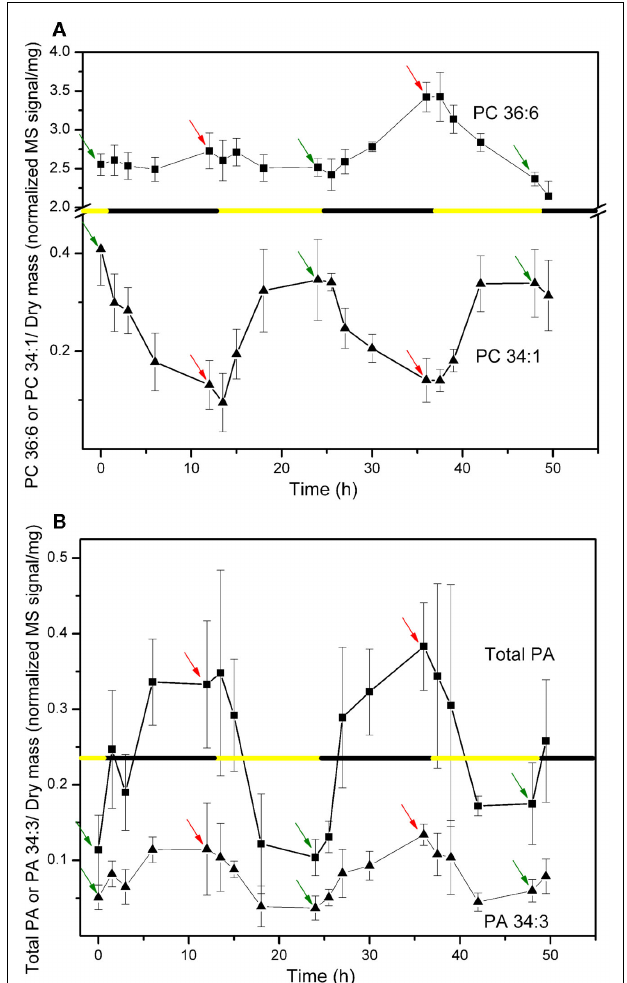
FIGURE 1 | Changes in lipid molecular species PC 36:6 and PC 34:1 (A) and PA lipid class and molecular species PA 34:3 (B) through 12-h light/12-h dark periods. Data are reported as normalized (to internal standard amounts) MS signal per extracted dry mass (in mg).The black and yellow line indicates the timing of the 12-h dark and light periods.The time indicated as 0h is the time of the first sampling, which occurred 11h into a 12-h light period (or 1h before the start of the first full dark period). In each panel, green arrows indicate the points 11h into the 12-h light periods and red arrows indicate the points 11h into the 12-h dark periods.These time points were chosen for later